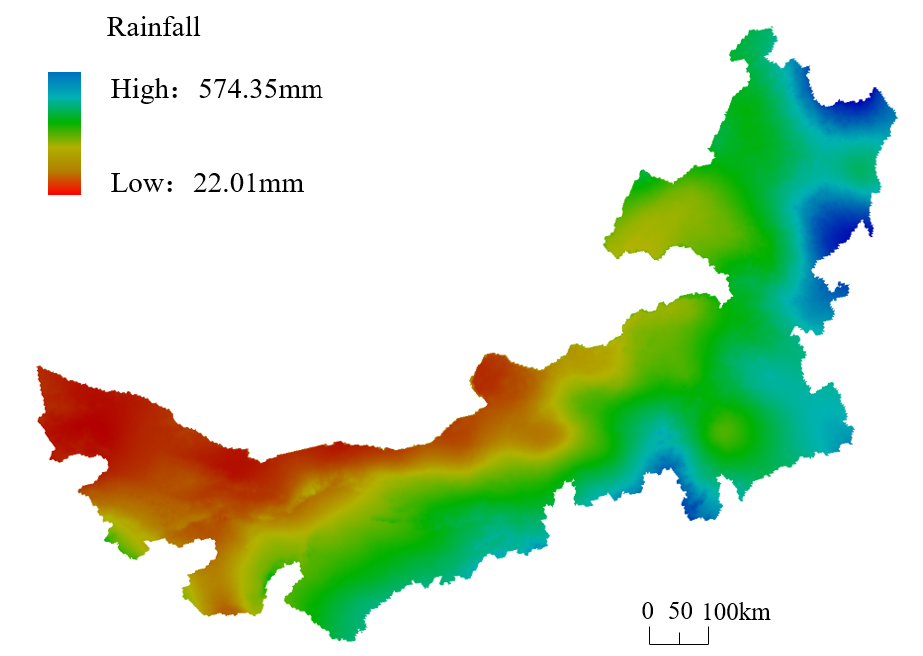
Figure 22. Inner Mongolia's average annual rainfall in 2015.